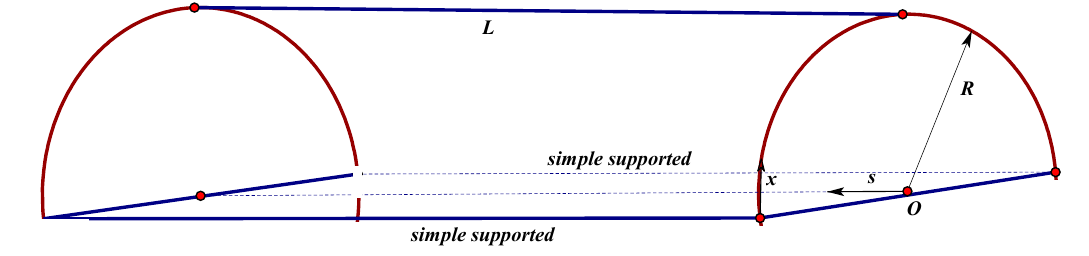
Figure 1. The diagram of a cylindrical coordinate.